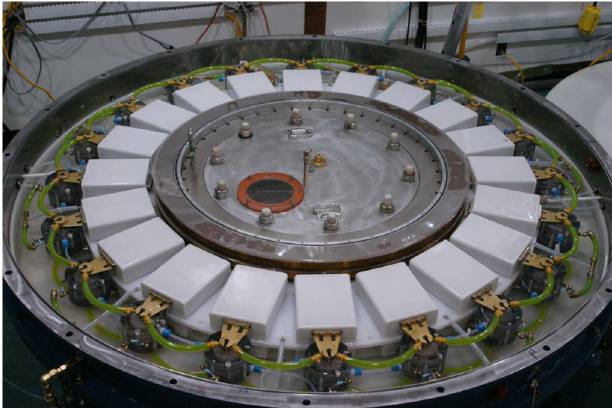
resistors.FIG. 4. Overview of the LTD-III cavity with 20 pairs of 40-nF capacitors, 20 switches and liquid charge and trigger resistors.